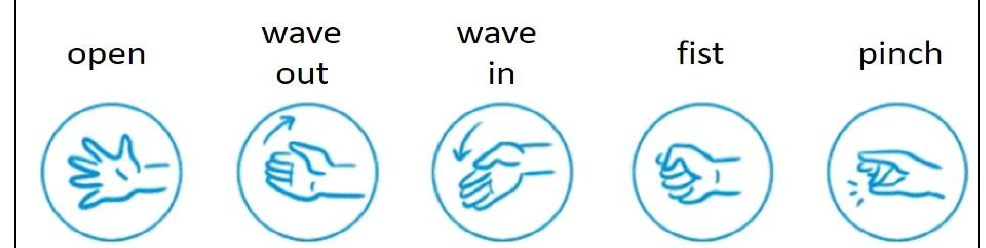
Figure 1. The 5 pre-defined Hand Gestures